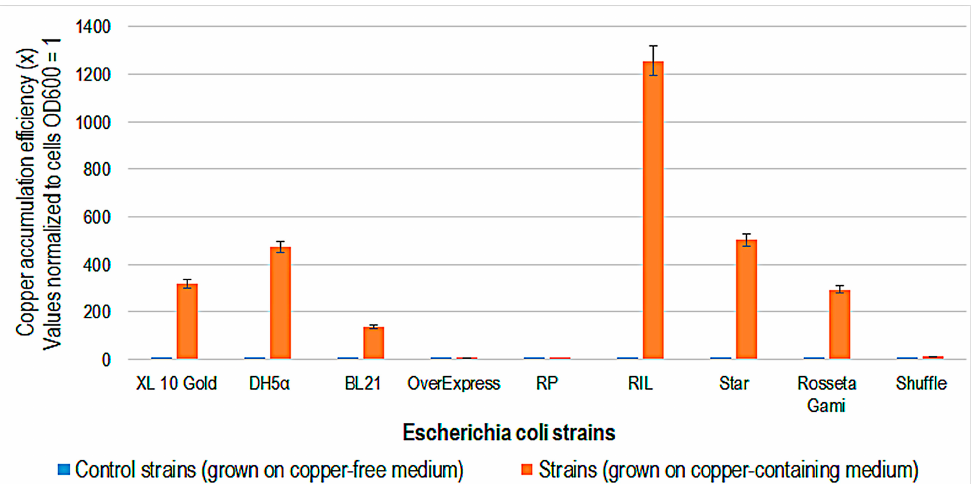
Figure 5. Copper accumulation efficiency (x) in different strains of Escherichia coli after 48 h growth in copper, containing Luria–Bertani medium at 35 °C. Control strains were grown on copper-free medium.